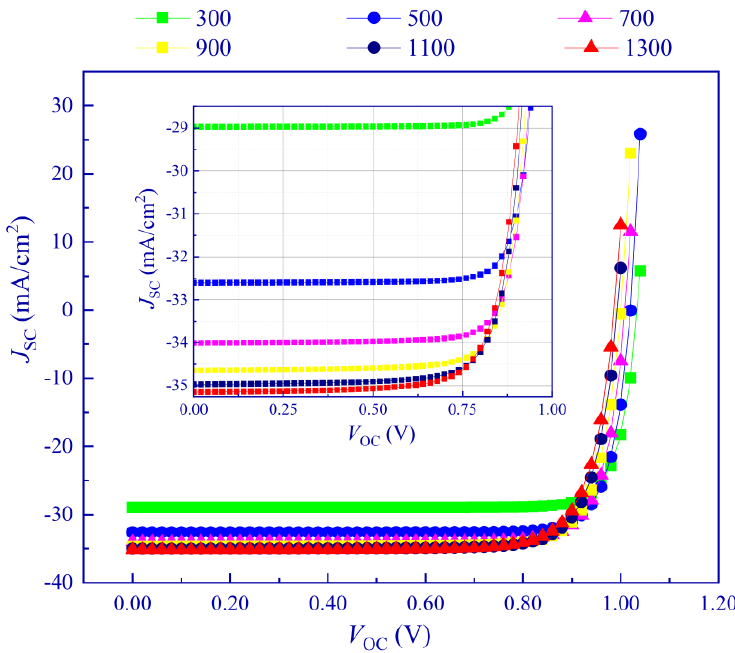
Figure 11. Current-voltage characteristic of a simulated photovoltaic cell FTO/TiO 2 / С H 3 NH 3 SnI 3 /Cu 2 O/Au with different thicknesses of the absorbing layer.